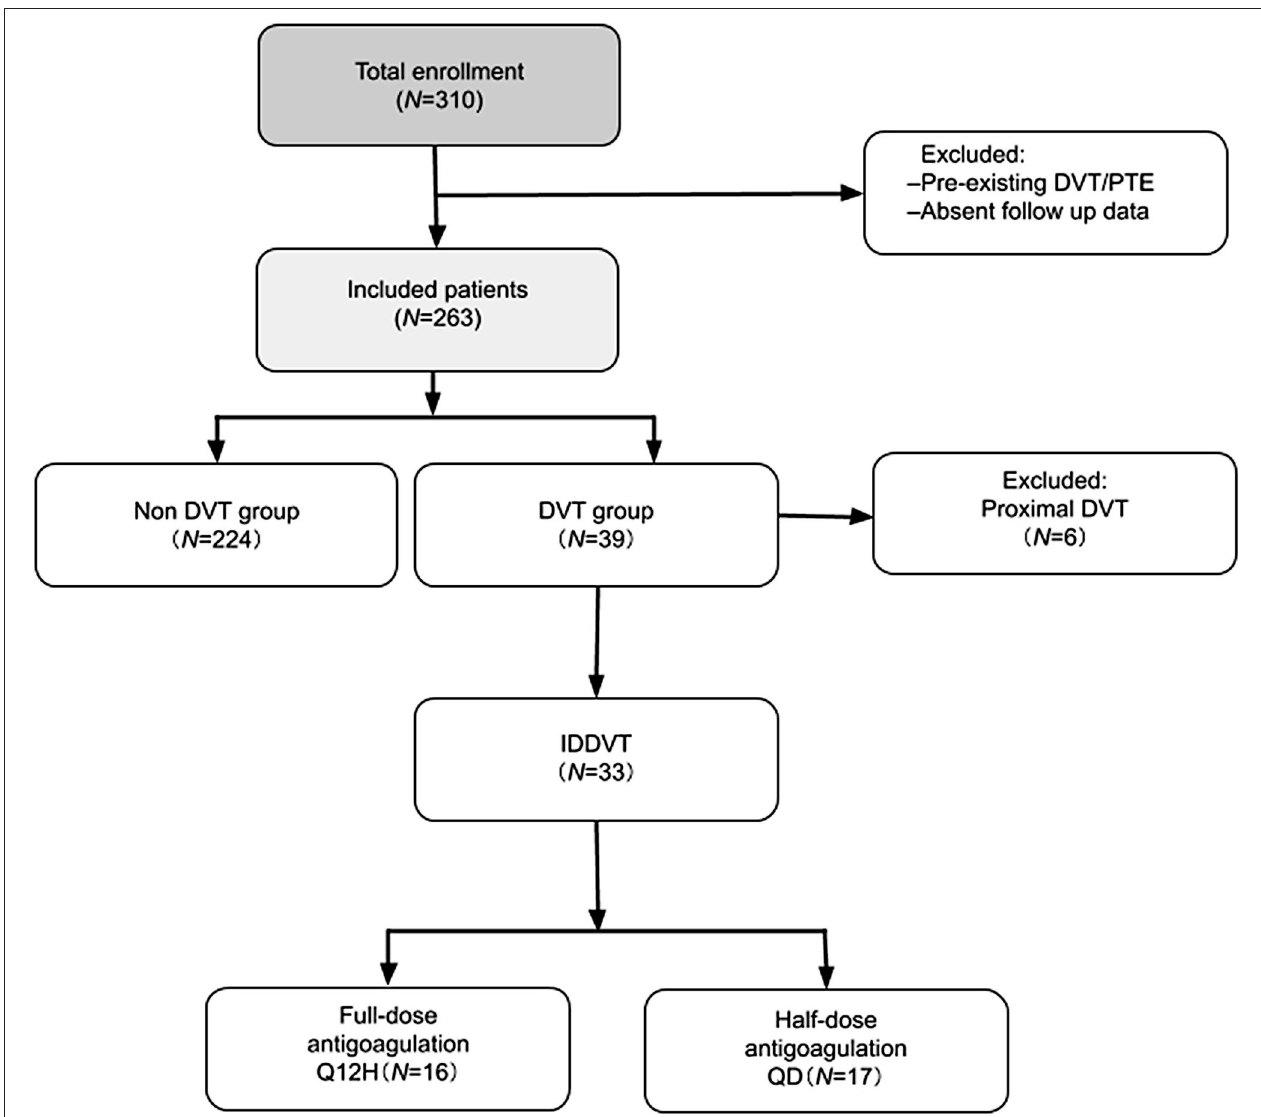
FIGURE 1 | Study flow diagram. PTE, pulmonary thromboembolism; DVT, deep venous thrombosis; IDDVT, isolated distal deep vein thrombosis; Q12H, every 12h; QD, once-daily.